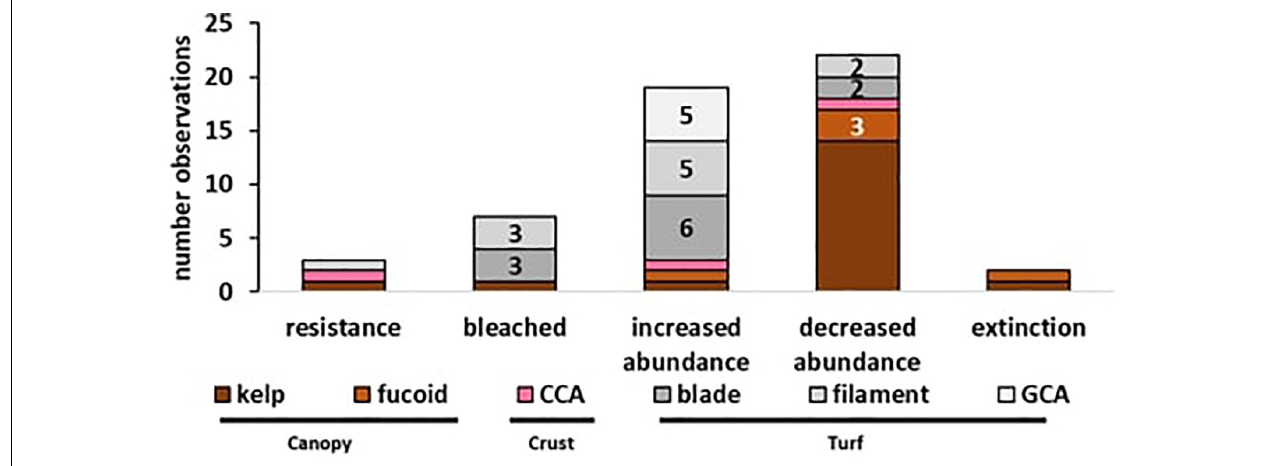
FIGURE 2 | Effects of MHWs on seaweeds ( n = 58 observations): Reported observations ranging from resistance, over bleaching, abundance changes (increase/decreased) to local extinction. Color coding represents the functional groups with (i) canopy (brown), (ii) crust (pink), and (iii) turfs (gray). Numbers represent count of observations where n ≥ 2, no number represents a single